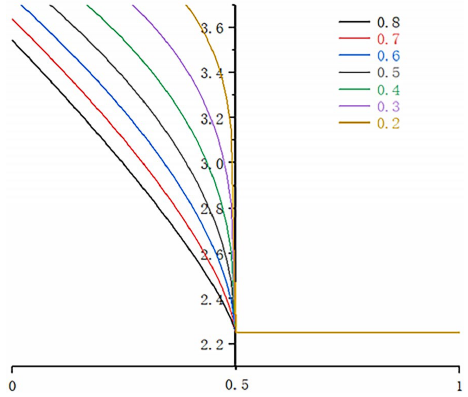
Figure 8. The weight curve when the consumers are risk